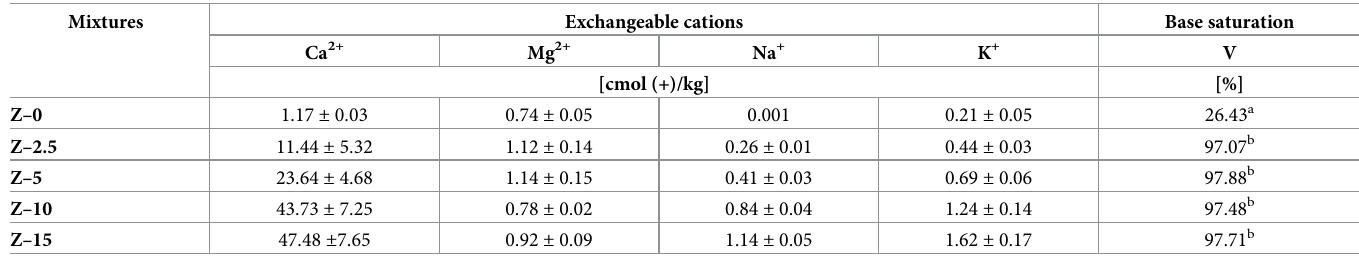
Table 5. Effect of drill cuttings on exchangeable cations content and the degree of base saturation in s soil and mixtures (average value ± standard deviation).